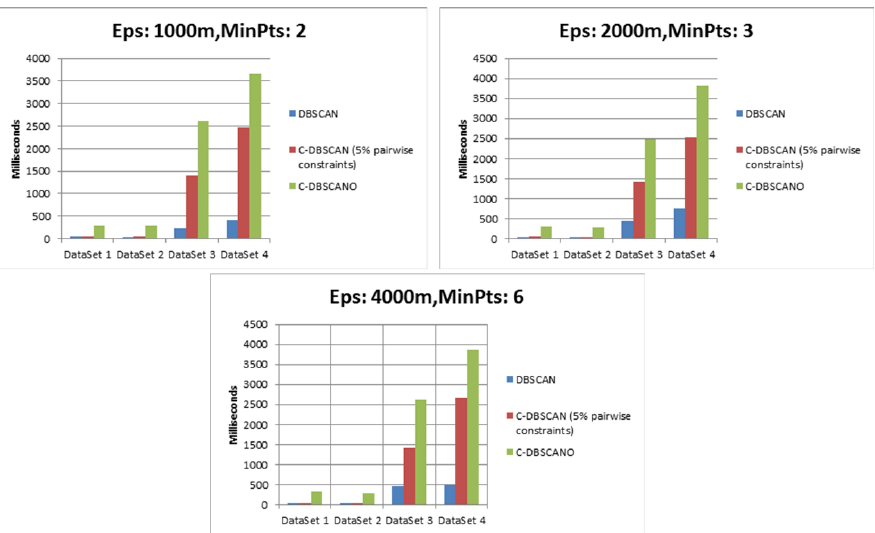
Figure 18. Performance comparisons with respect to run time (milliseconds).